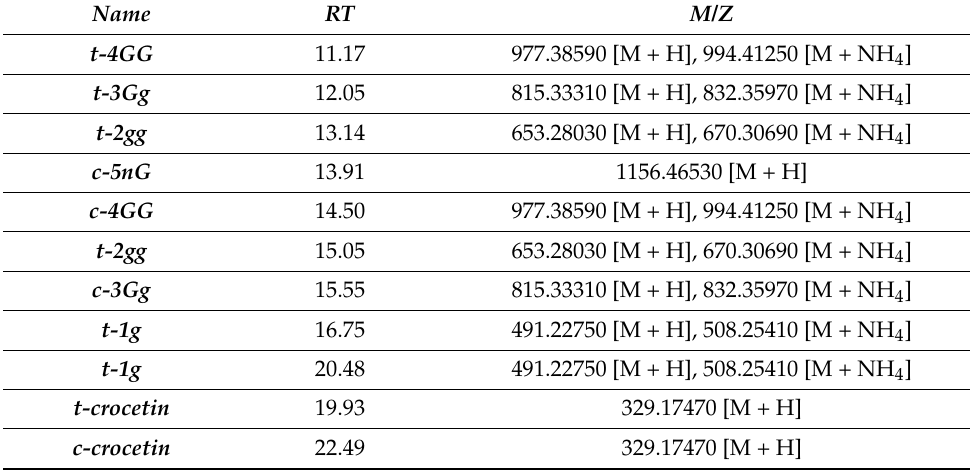
Table 1. List of saffron apocarotenoids found in the stigma and in the in vitro reactions in the HPLC-DAD chromatograms, detected at 440 nm, separated with a C18 column, and identified by high-resolution mass spectrometry (HRMS) analyses. RT : retention time. M / Z : detected mass /